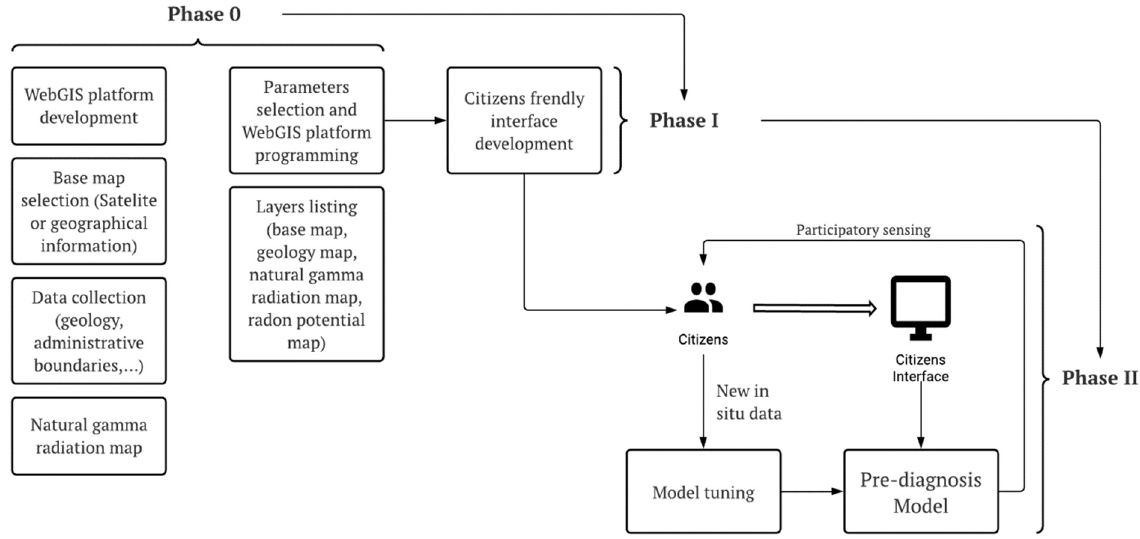
Figure 1. Flowchart of the methodology for radon potential mapping.